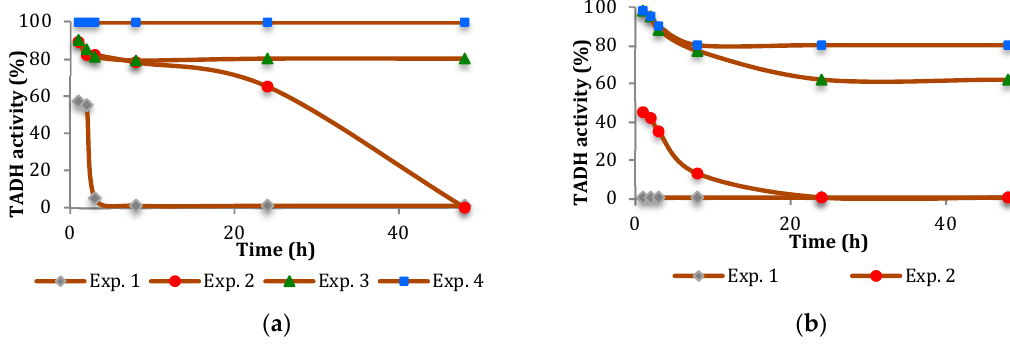
Figure 2. TADH activity (%) versus incubation time (hours) in samples made by Pt NPs incubated with different TADH volumes; NPs were of two different dimensions: ( a ) 8 nm; ( b ) 19 nm. The experimental conditions were: Exp. 1, 10 μ L of Pt NPs solution and 50 μ L of TADH; Exp. 2, 10 μ L of Pt NPs and 100 μ L of TADH; Exp. 3, 10 μ L of Pt NPs solution and 800 μ L of TADH; Exp. 4, 10 μ L of Pt NPs and 3 mL of TADH (see experimental).